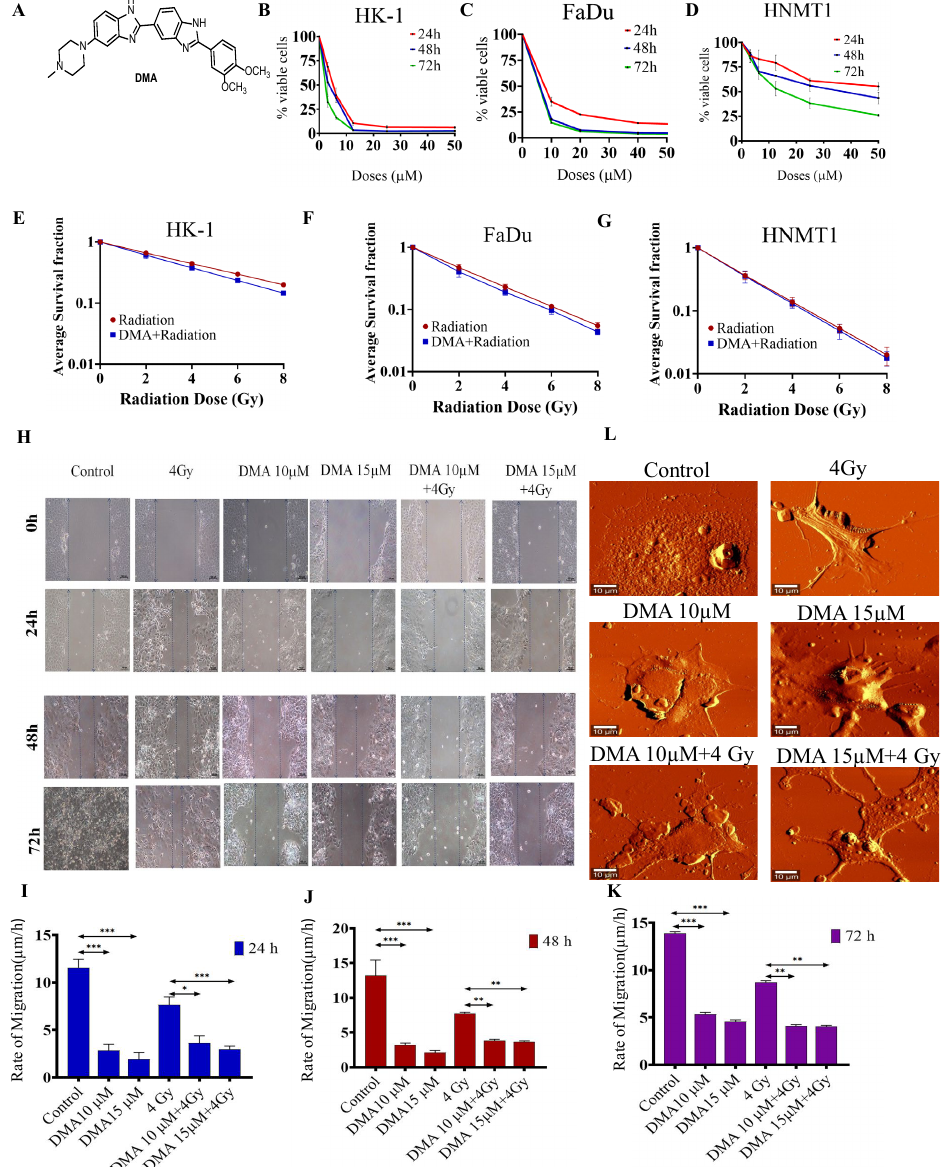
Figure 1. DMA treatment induced the killing of cancer cells and decreased cell migration in head and neck cell lines and HNMT1 primary cells. ( A ) Chemical structure of DMA. Cytotoxicity of DMA on ( B ) HK-1, ( C ) FaDu, and ( D ) tongue squamous cell carcinoma patient-derived primary (HNMT1) cells determined through MTT assay.( E – G ) Clonogenic survival curves of HK-1, FaDu,